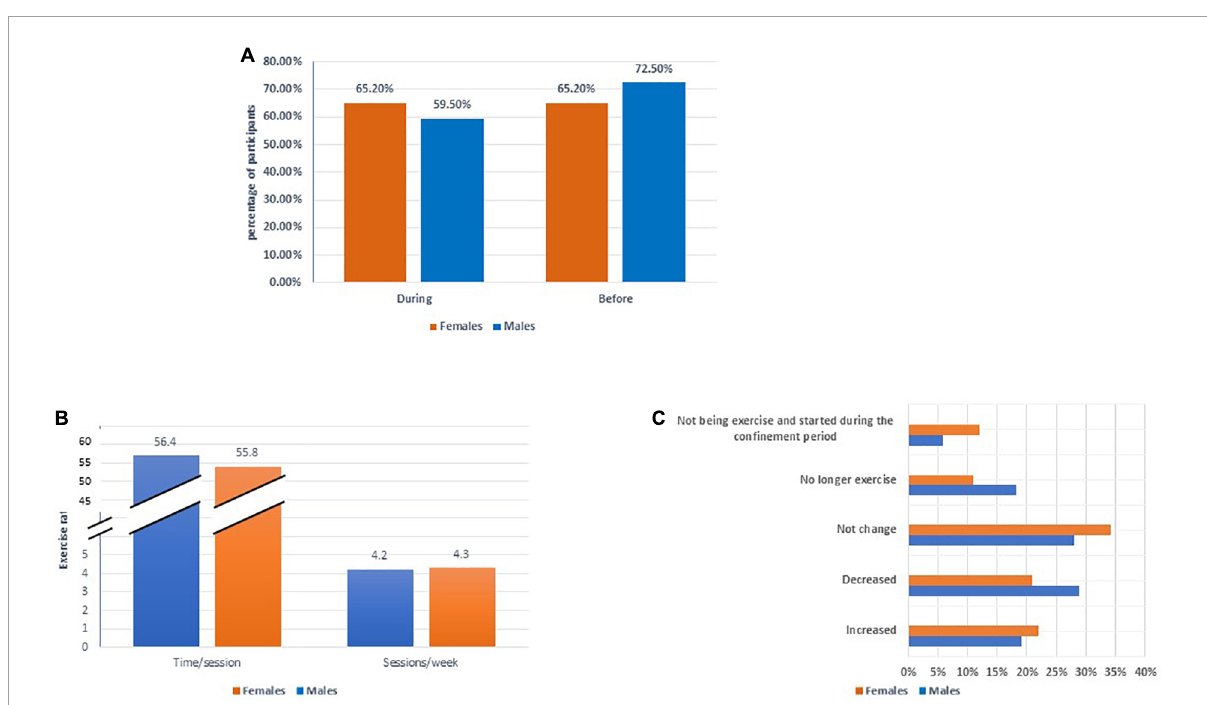
FIGURE2 Gender differences in exercising during the confinement period. (A) Exercising according to gender before and during the confinement period. (B) Cause to stopping following healthy diet during the confinement period. (C) Changes in exercise rate during the confinement